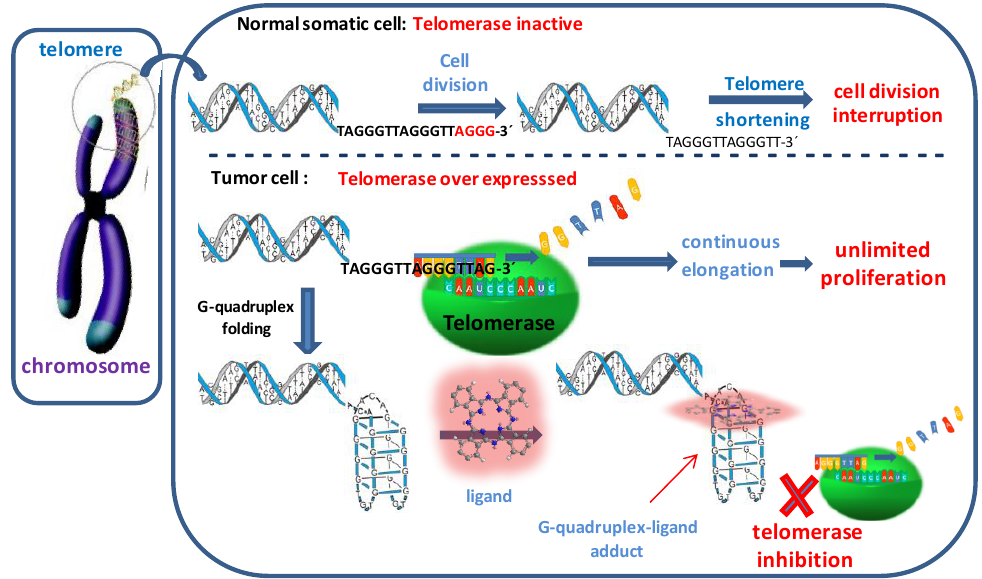
Figure 1. Schematic demonstration of telomerase inhibition by formation and stabilization of G-Quadruplex structures.